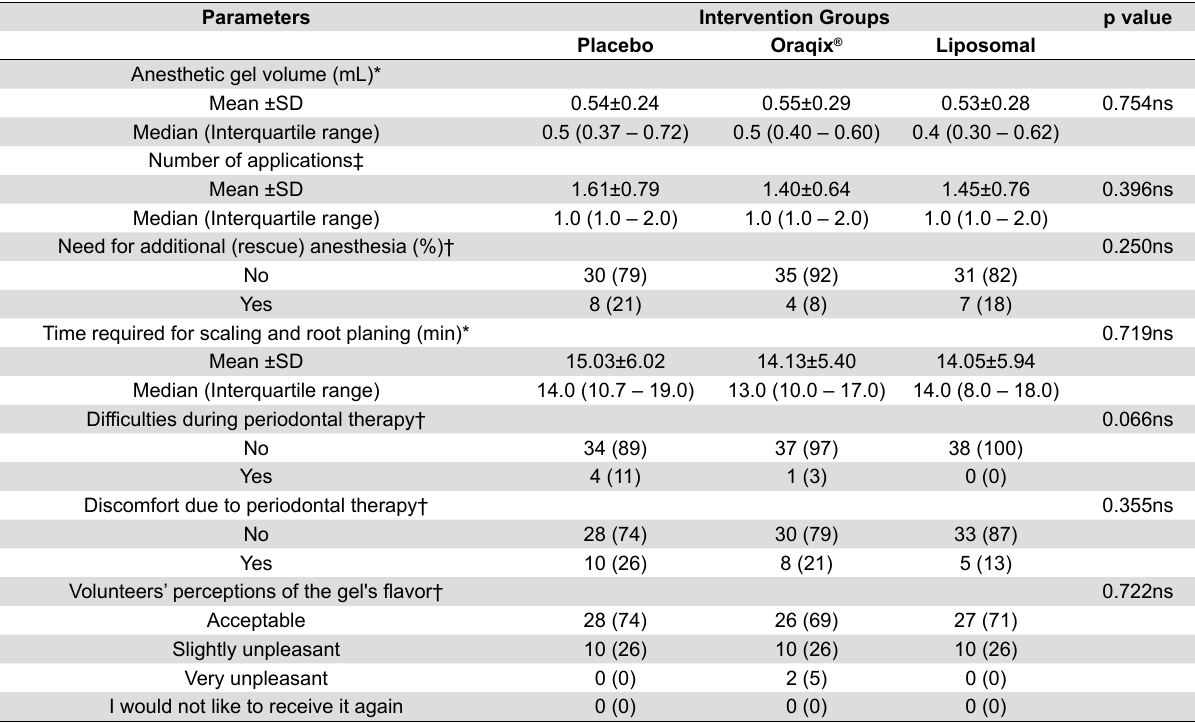
Table 4- Data obtained in trans- and postoperative scaling and root planing in the three intervention